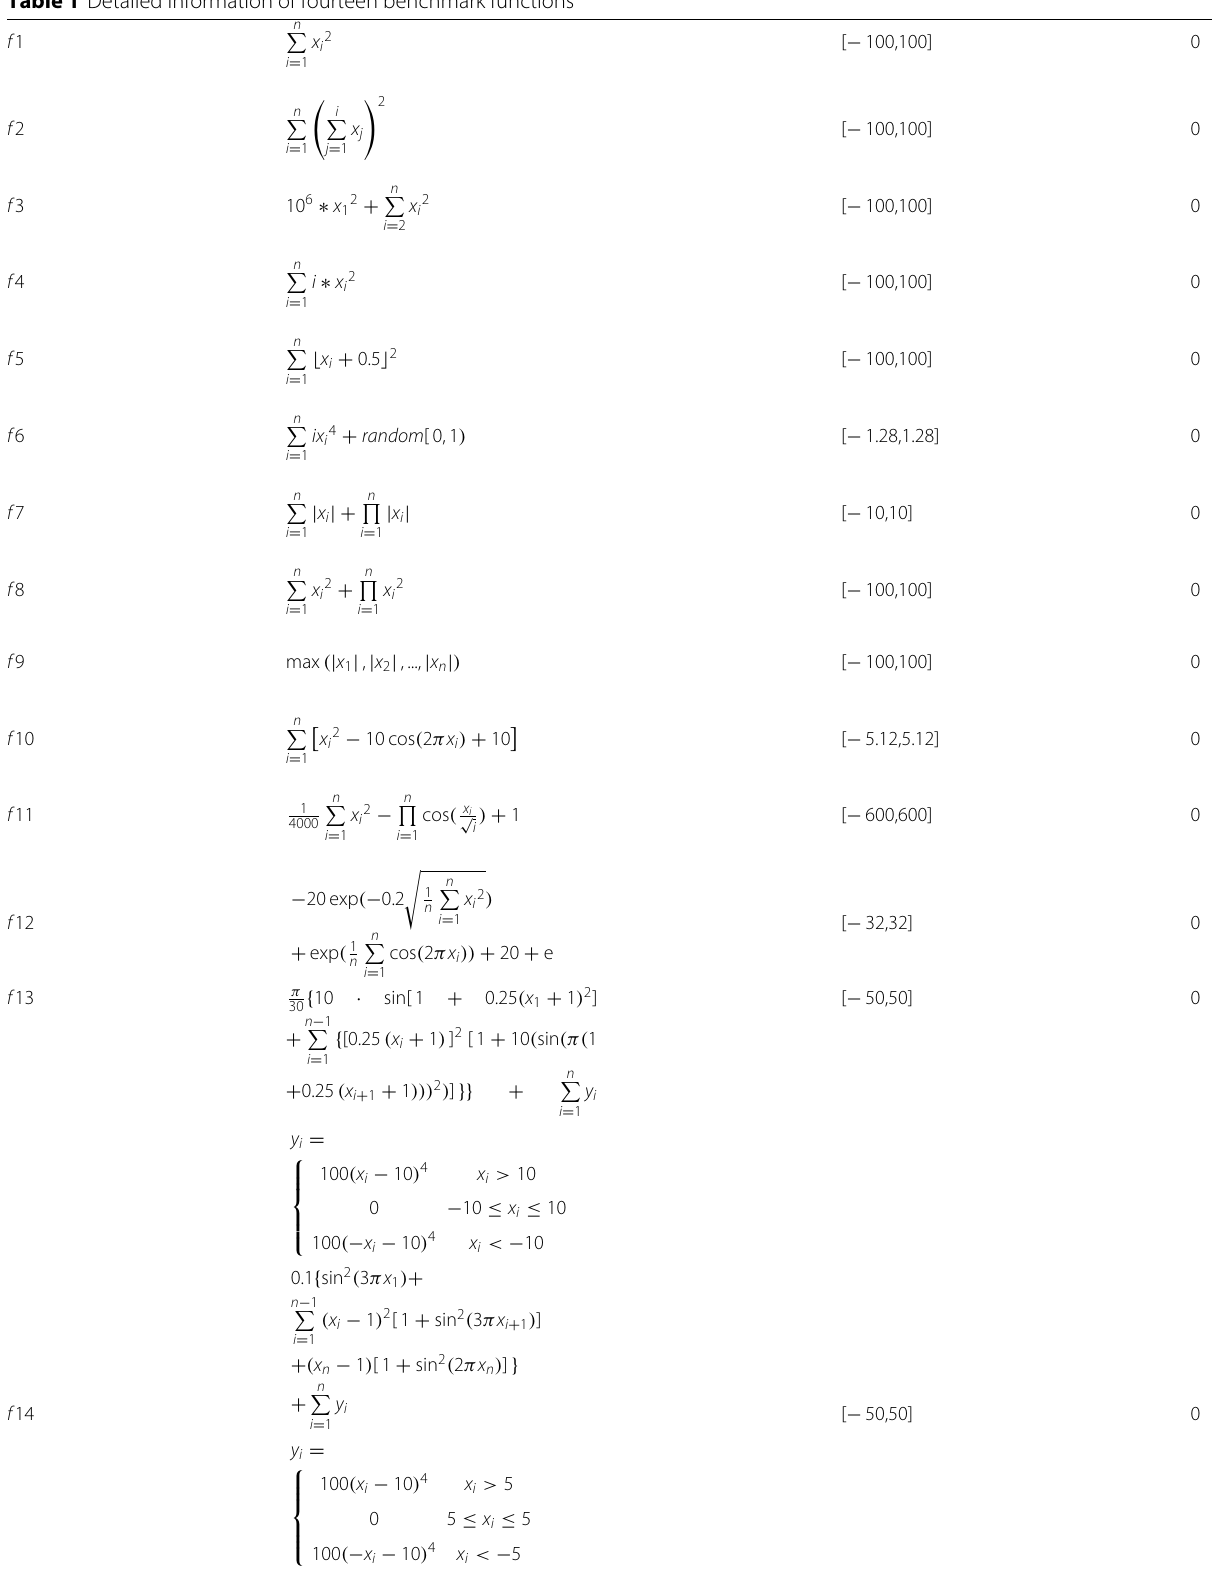
Table 1 Detailed information of fourteen benchmark